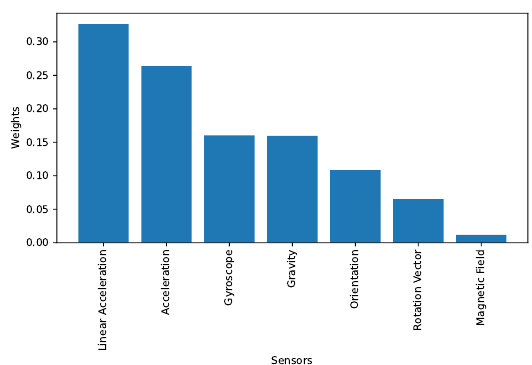
Figure 15. Attention weights of each